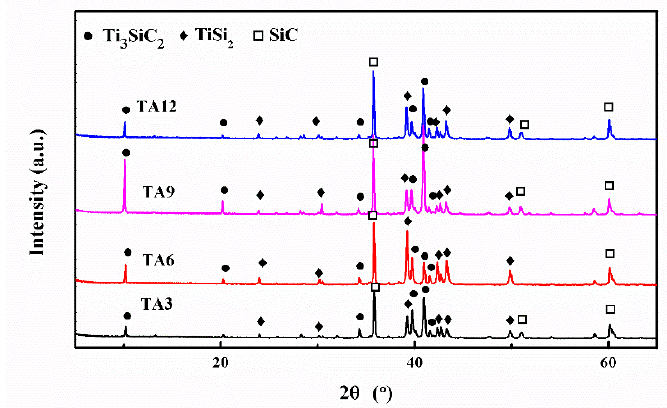
Figure 1. XRD patterns of samples TA3, TA6, TA9, and TA12.